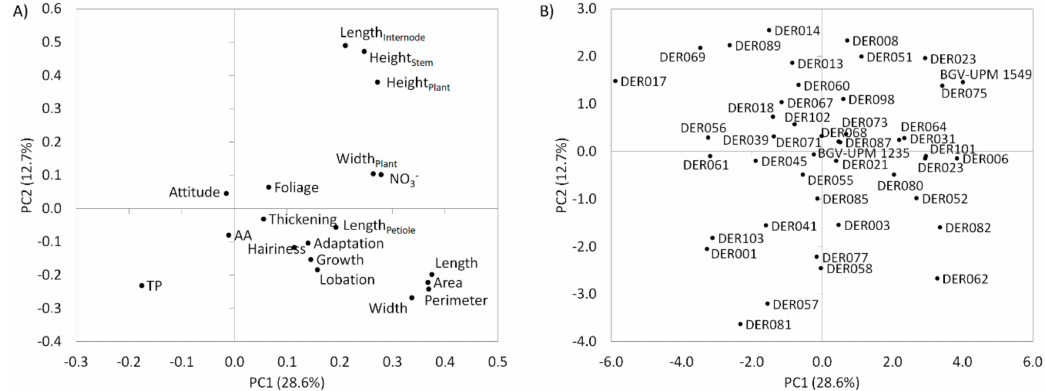
Figure 5. Principal Component Analysis (PCA) for the first and second principal components, performed with the quantitative plus qualitative ordinal data. ( A ) The PCA loading plot. ( B ) The PCA score